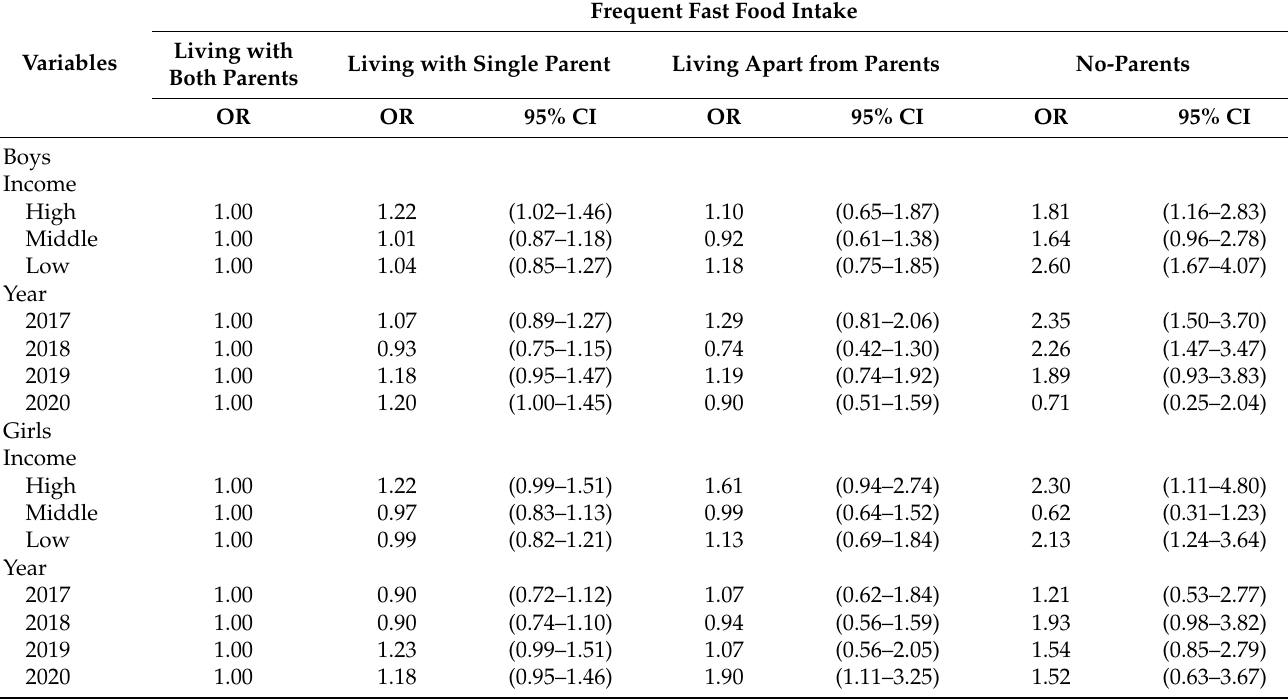
Table 3. The results of subgroup analysis stratified by independent variables.